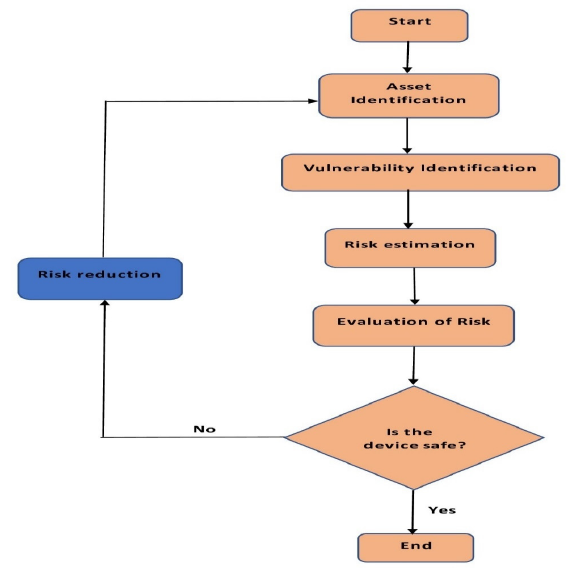
Figure 17. Risk assessment flowchart .